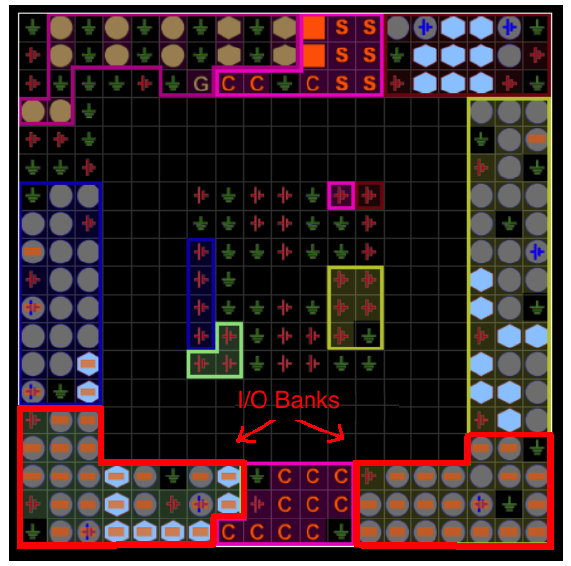
Figure 5. I/O pin mapping representation of trojan-inserted